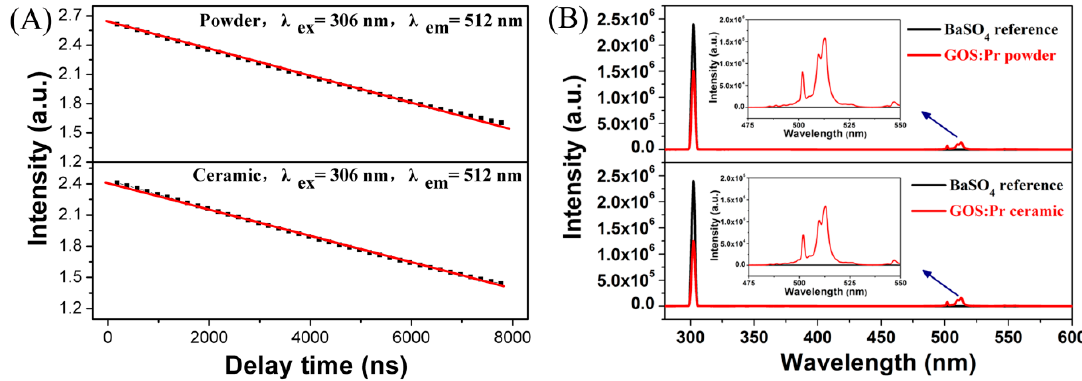
Figure 7. Fluorescence decay behaviors of the GOS:Pr phosphor powder and scintillation ceramic for the 512 nm Pr 3+ emission under 306 nm excitation ( A ) and their quantum efficiency spectra obtained under 306 nm excitation ( B ).